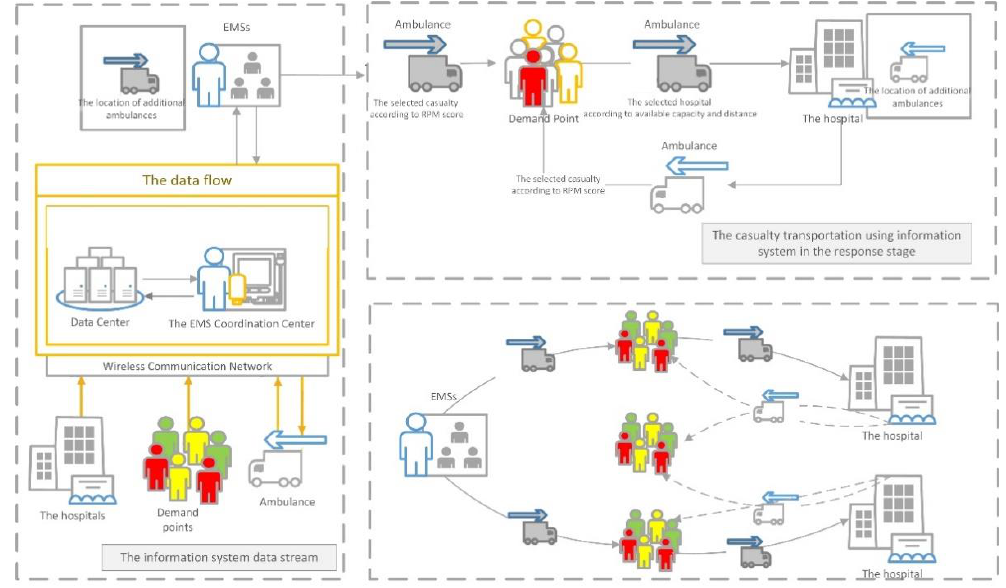
Figure 2. The casualty transportation system design.